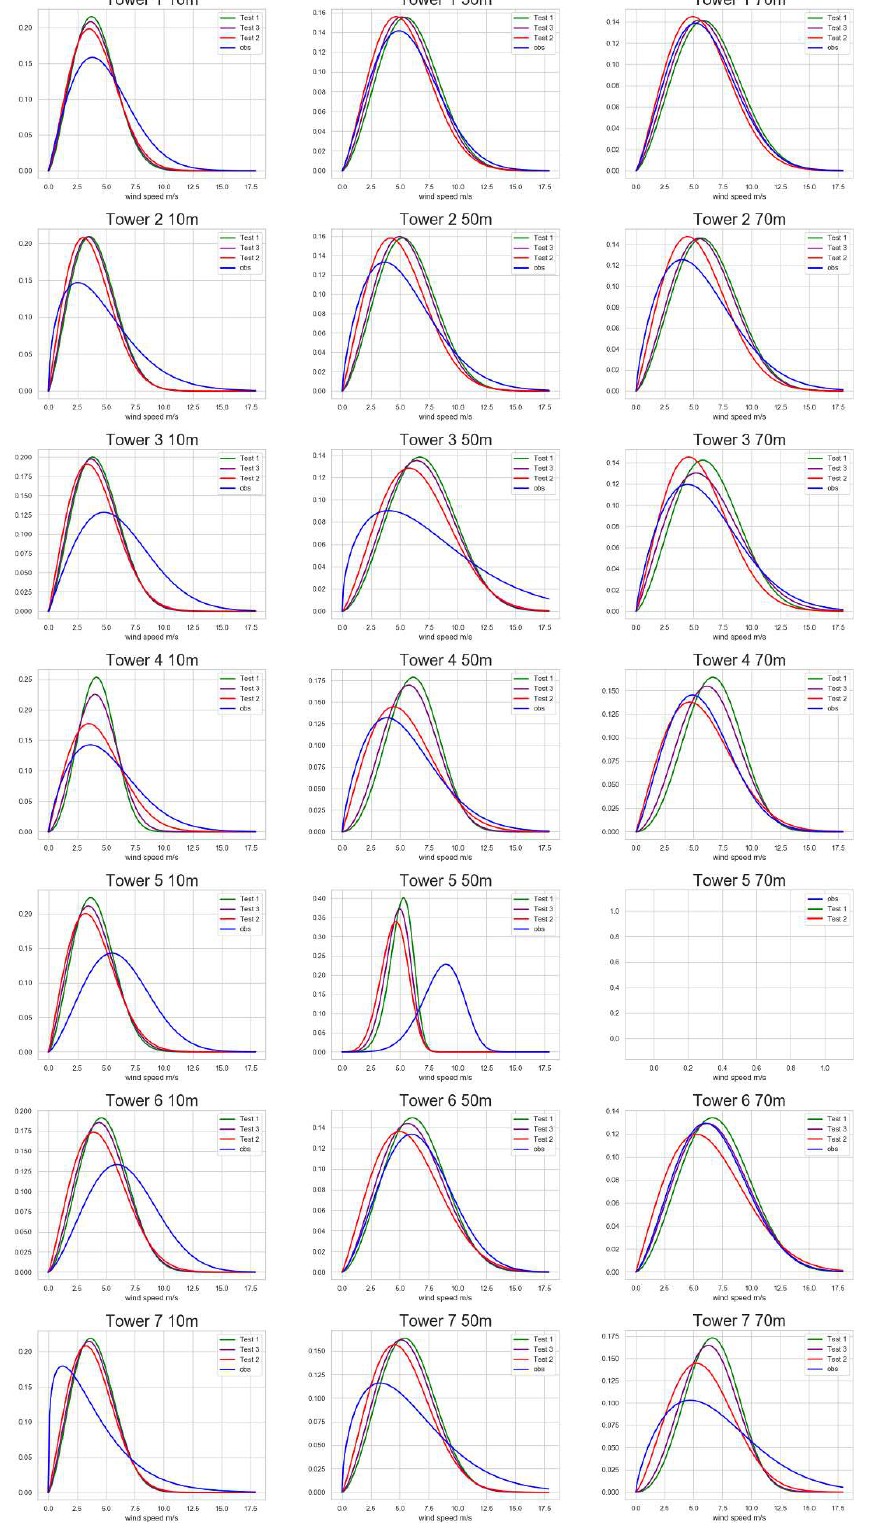
Figure 6. The Weibull distribution of seven towers at different heights. The blue lines are the observed wind speeds, the green lines are the results of Test 1 (no data assimilation), and the red lines are the results of Test 2 (data assimilation).